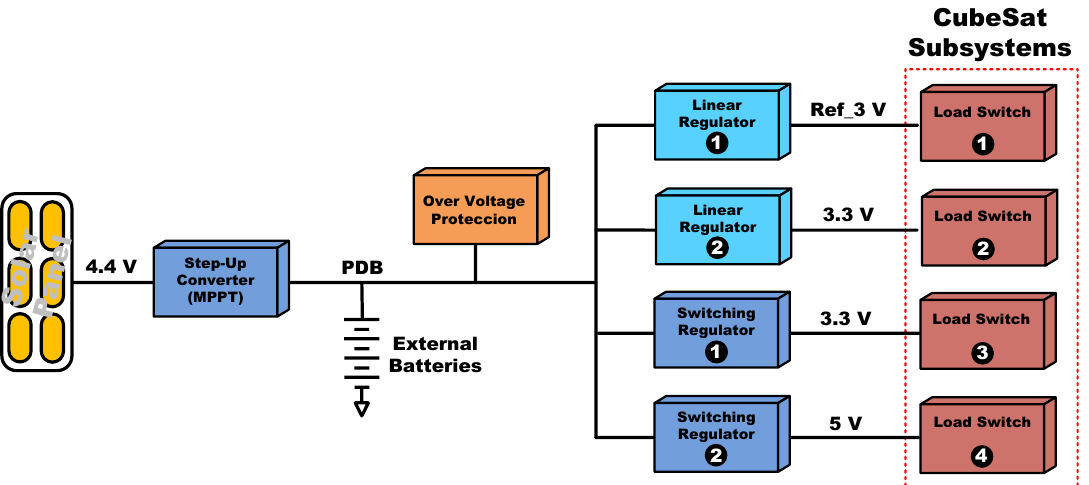
Figure 19. Block diagram of Electric Power Supply subsystem of a satellite (CUBEsat).